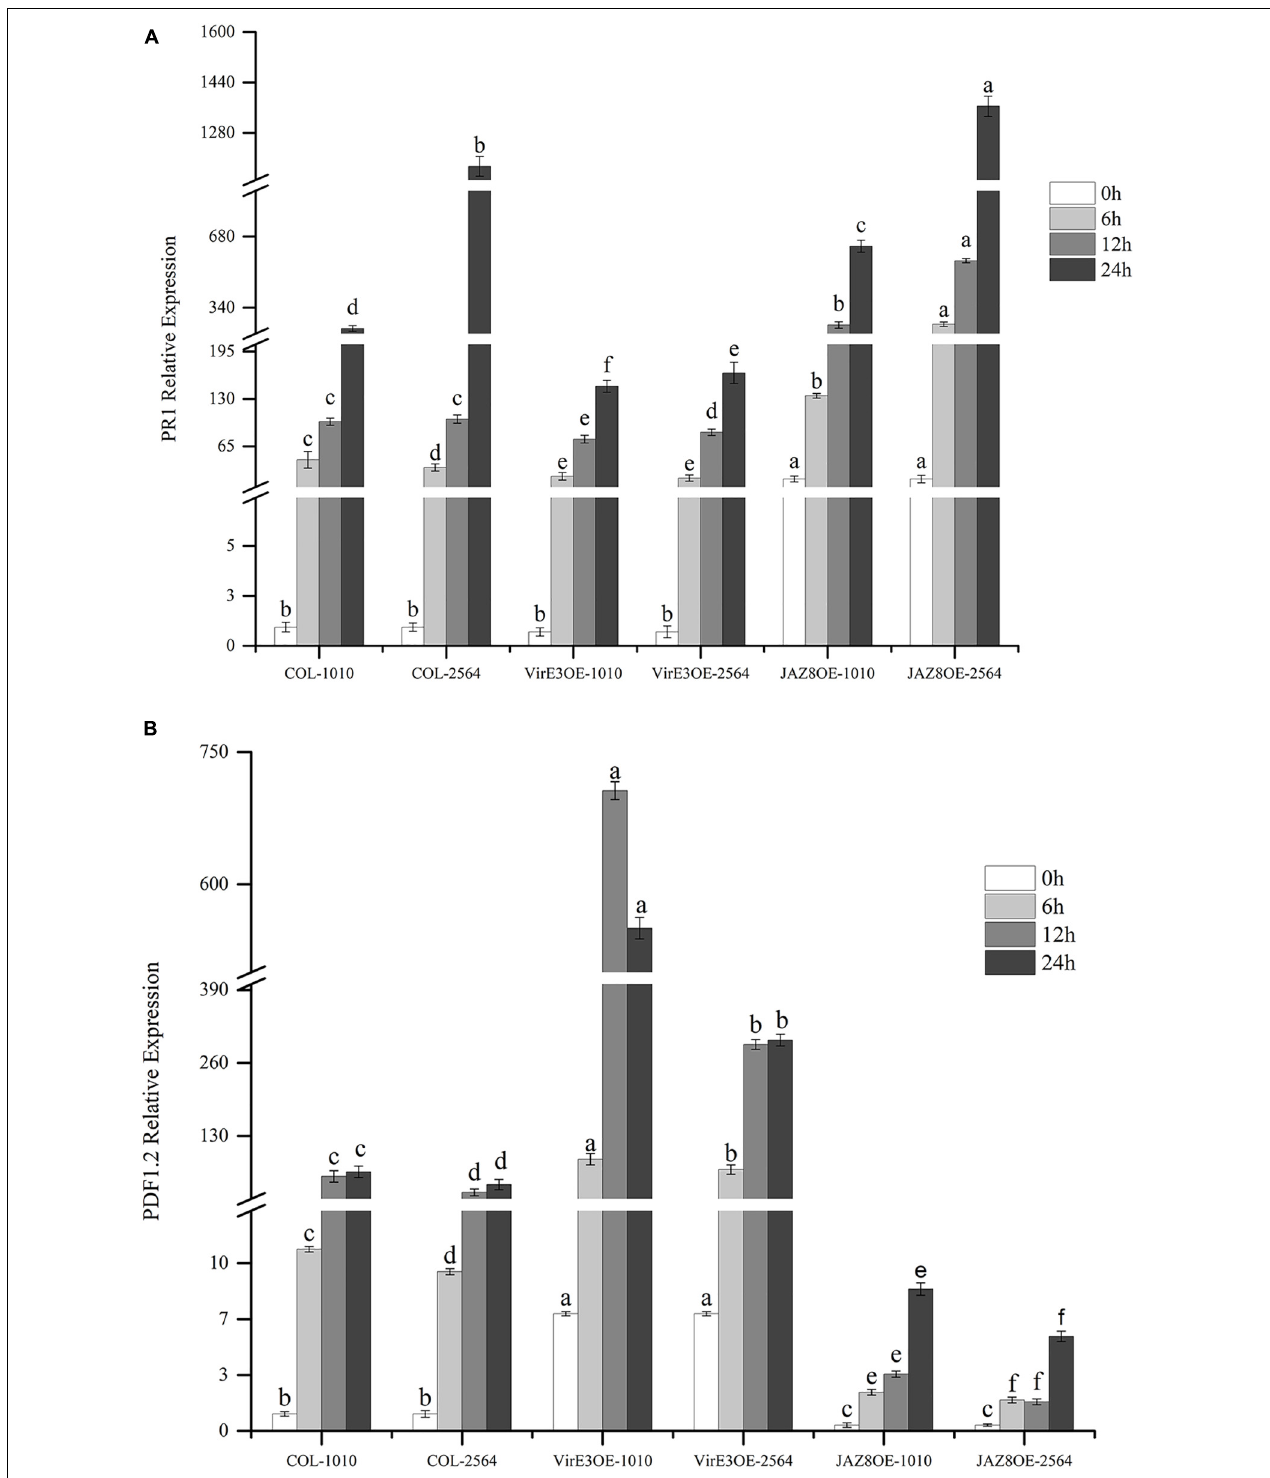
FIGURE 5 | Quantification of AtPR1 and AtPDF1.2 gene expression level in Col-0, virE3 -OE and JAZ8 -OE1 lines after infection with Agrobacterium LBA1010 and LBA2564 at different time points. (A) qRT-PCR analysis of AtPR1 gene expression pattern. (B) qRT-PCR analysis of AtPDF1.2 gene expression pattern. EF1a was used as internal control for data normalization. The expression level of PR1 and PDF1.2 in the wild-type Col-0 at 0 h was set to 1.0, and error bars represent SEM of three independent biological replicates. The expression values of PR1 and PDF1.2 in virE3 -OE and JAZ8 -OE lines were compared to the control Col-0 at each corresponding condition. Differences indicated by different letters are statistically significant ( P values < 0.05) and by the same letter are not statistically significant.